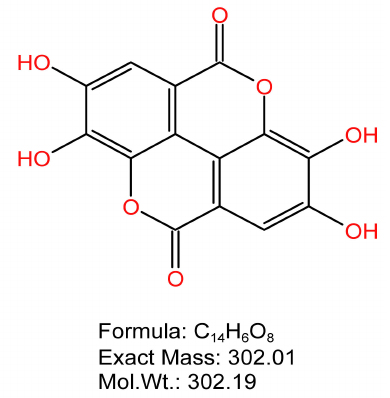
Figure 1. The structural formula of ellagic